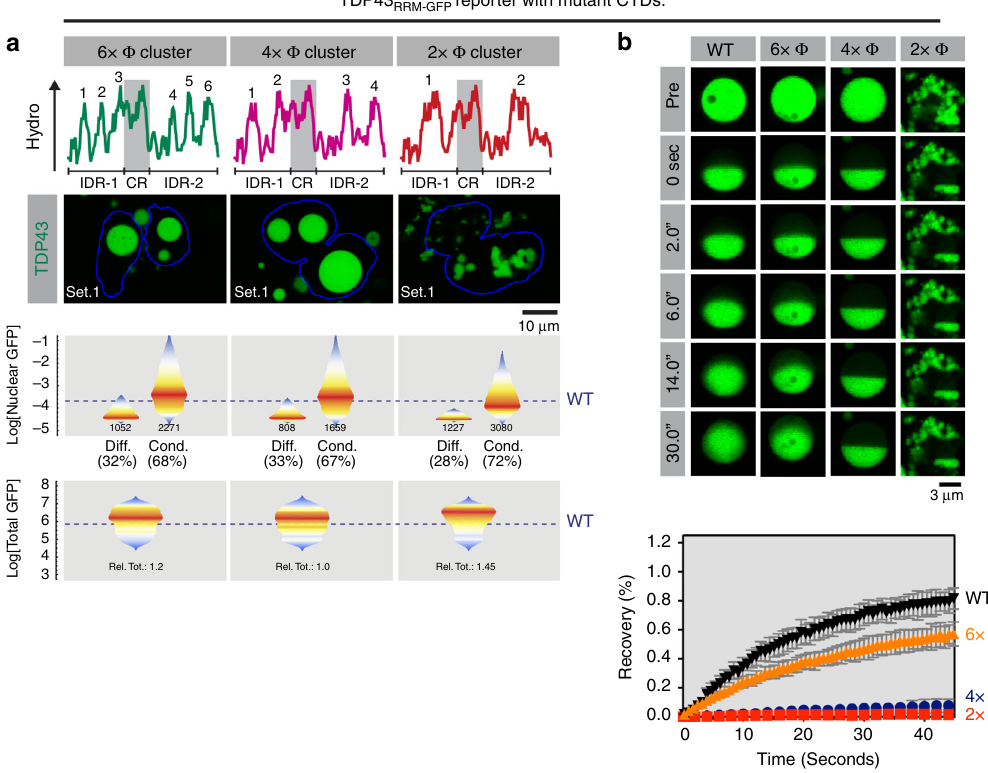
Fig. 5 The spacing of hydrophobic CTD residues dictates TDP43 RRM-GFP condensate properties. a Hydropathy plots (with numbers denoting hydrophobic peaks), cellular distribution, nuclear abundance and total cellular abundance of TDP43 RRM-GFP variants with altered spacing between hydrophobic peaks. Data are represented as in Fig. 2 ( n ≥ 2400 and 10,000 cells for nuclear and total GFP levels, respectively), except that dashed blue lines represent the median nuclear GFP levels of cells with WT TDP43 RRM-GFP condensates or the median total abundance of WT TDP RRM-GFP (see Fig. 2). See Supplementary Fig. 2 for an illustration of how the mutants were constructed by sliding hydrophobic clusters. b Material properties of condensates formed by TDP43 RRM- GFP variants probed by half-bleach FRAP (as in Fig. 2b, c). Plot markers represent mean values and error bars standard deviation ( n